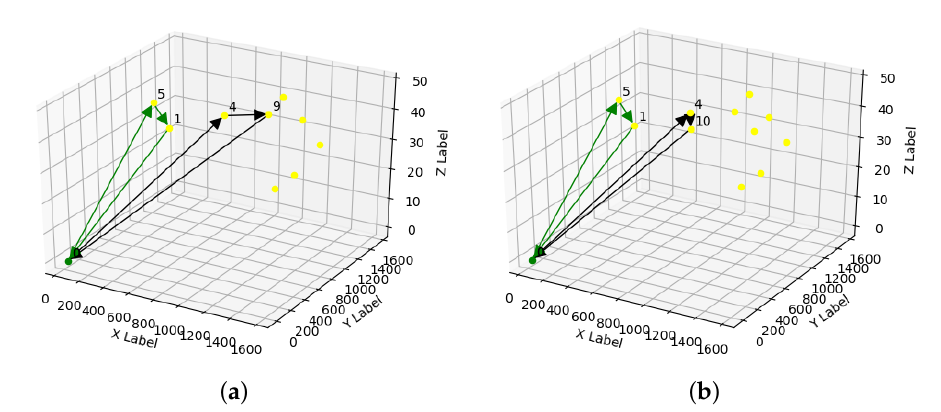
Figure 5. Routes with equal and different storage capacity. ( a ) Route with 9 points. ( b ) Route with 11 points.